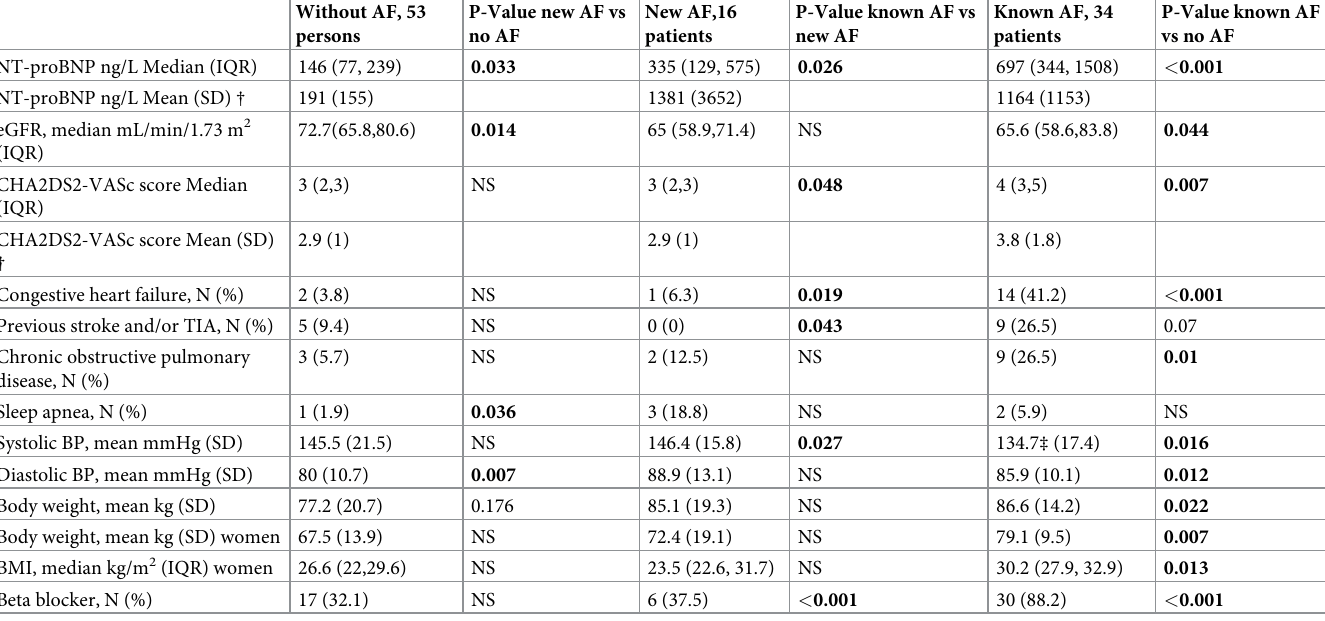
Table 2. Variables with statistically significant differences regarding AF among participants who were assessed for